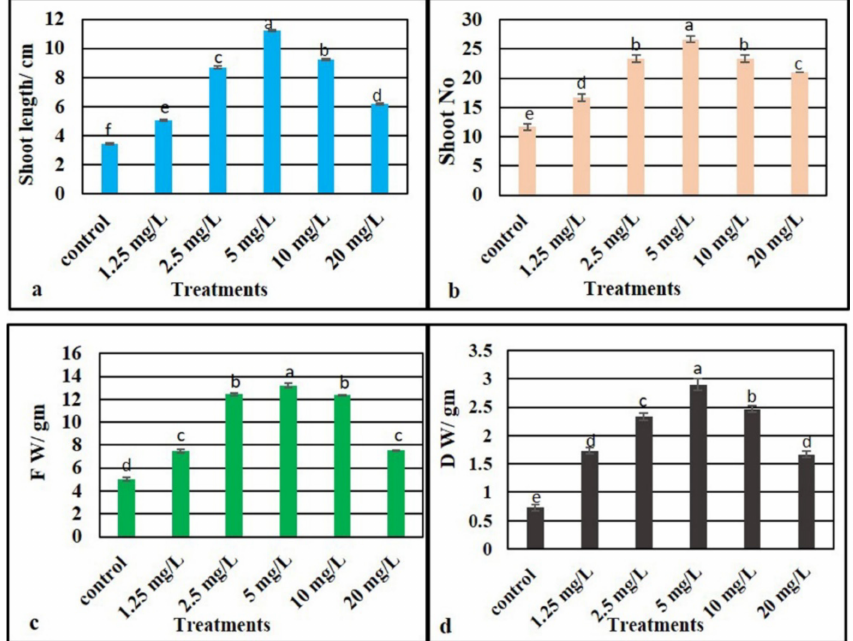
Figure 5. Influence of ZnO NPs on the in vitro regeneration of M. oblongifolia after 45 days of treatment in MS media: shoot length ( a ); shoot number ( b ); fresh weight ( c ); and dry weight ( d ). Means ± SD for each treatment followed by the same letters are not significantly different according to one-way analysis of variance ( p ≤ 0.05).